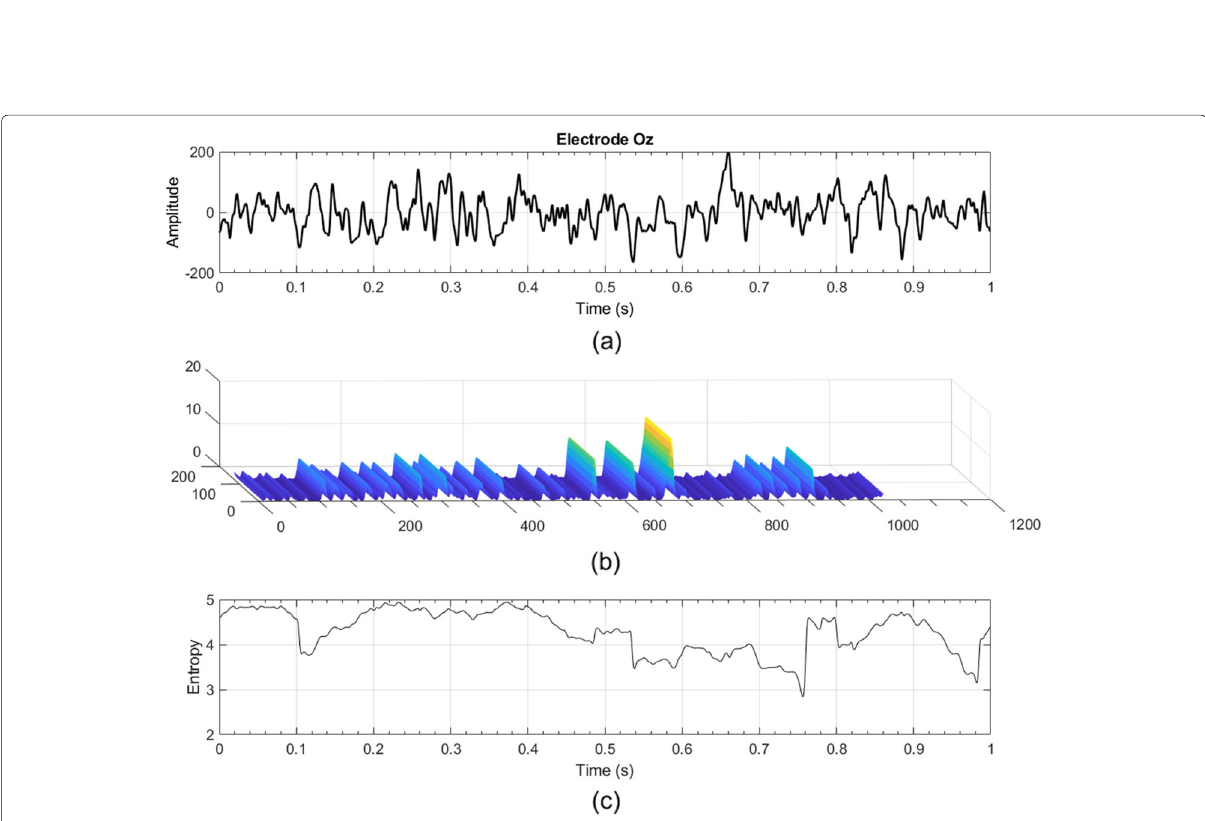
Fig. 10 Electrode Oz. a Time domain representation of ERP. b SPWVD time-frequency representation . c Short-term Rényi entropy of the